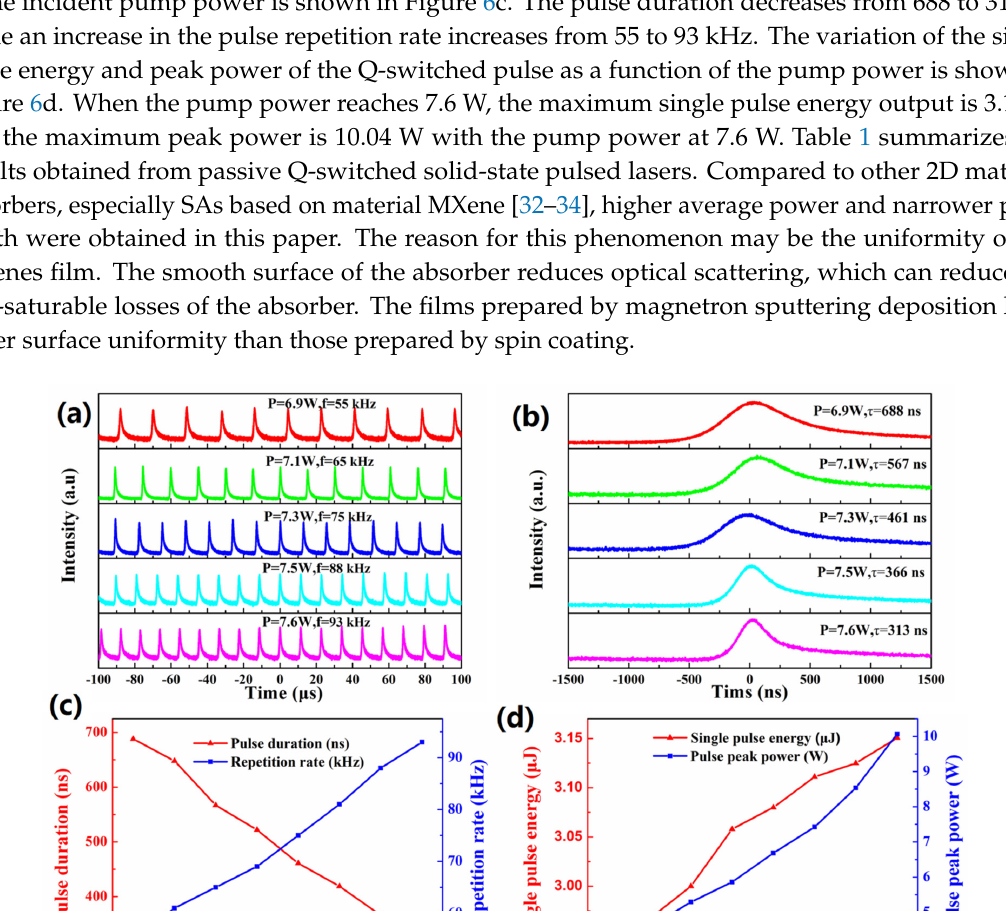
Figure 6. ( a ) Pulse trains and ( b ) Single pulse profiles of the Q-switched Nd:YVO 4 laser; ( c ) Evolution of the repetition rate and pulse duration with the pump power; ( d ) Single pulse energy and peak power curves.